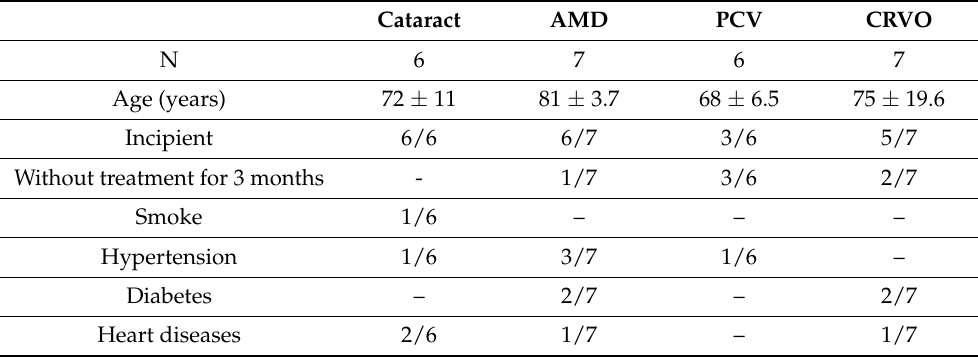
Table 1. Demographic characteristics of the group with cataracts (control subjects) and patients with different retinal